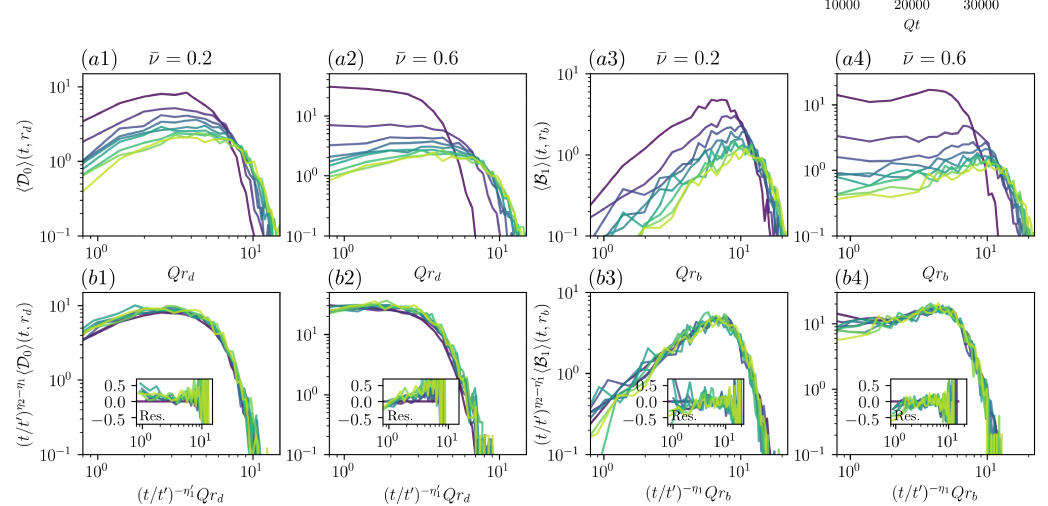
Figure 6: Birth and death radii distributions in the infrared. Columns 1 and 2: Death radii of of zero-dimensional homology classes. Columns 3 and 4: Birth radii of one- dimensional homology classes. Individual columns show data for the indicated filtra- tion parameter, ¯ ν . Row 1: unrescaled distributions. Row 2: rescaled distributions. The employed time-dependent scaling exponents are displayed in Fig.